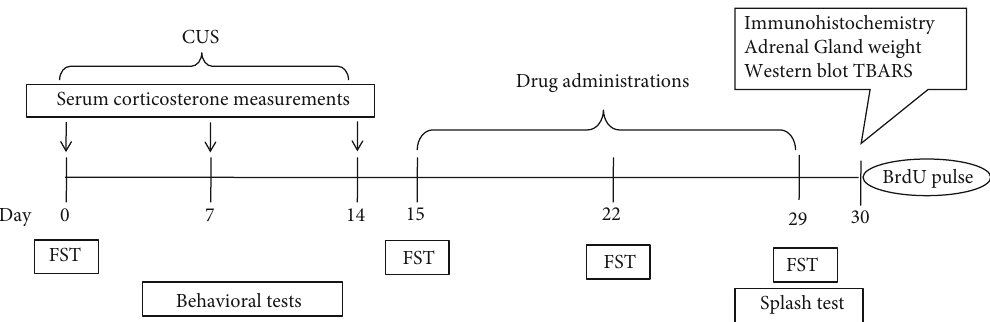
Figure 1: Schematic representation of the experimental design. On day 0 of the experimental protocol, mice performed the pretest for forced swimming test (FST) and habituation for splash test, then were subjected to the CUS protocol (corticosterone measurements were made on a separate group of mice). On day 15, there was another FST evaluation before treatment administration and this was repeated on days 22 and 29 (last day splash test was